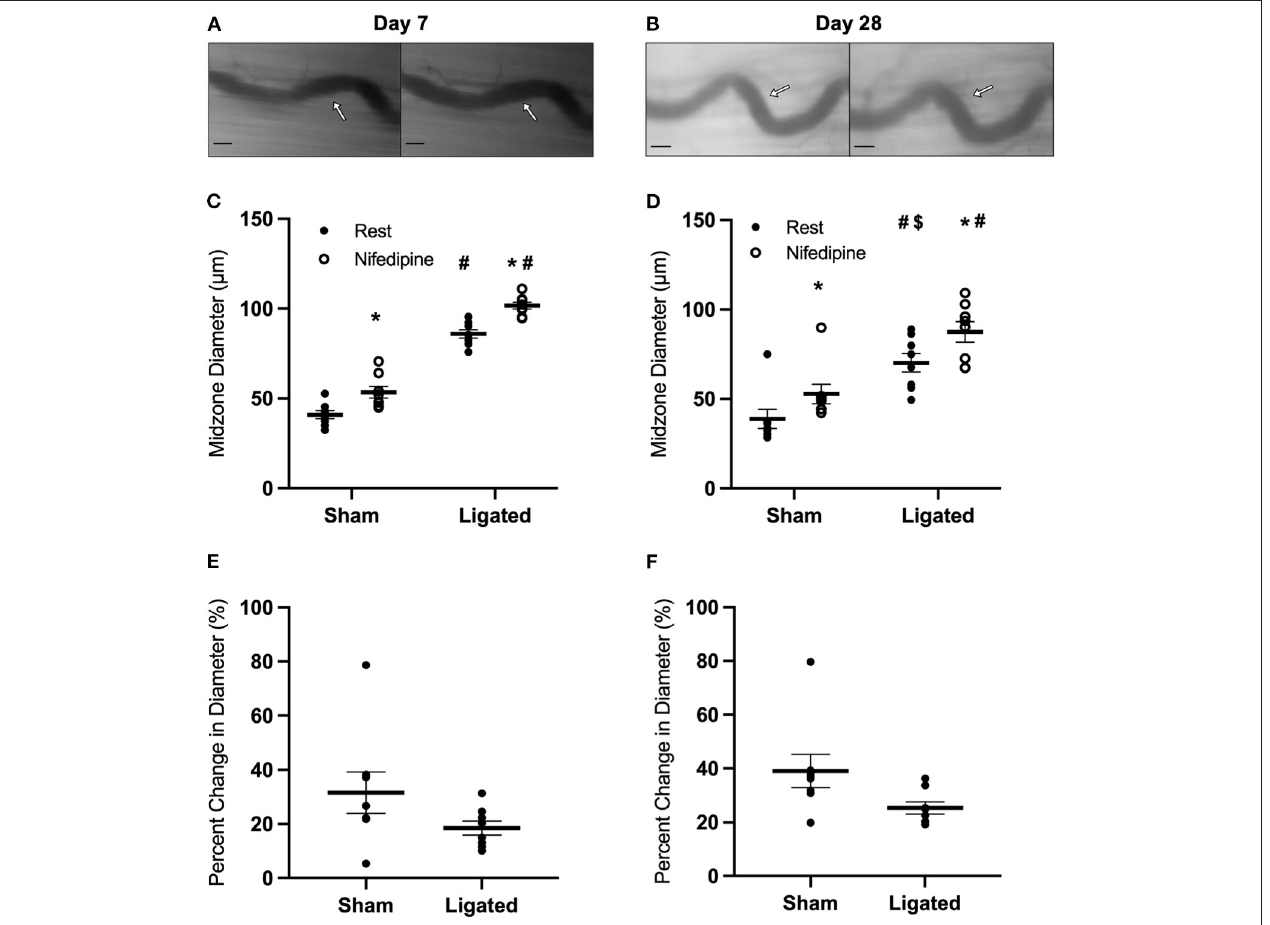
FIGURE 4 | Collateral vessels are not more sensitive to L-type calcium channel inhibition at day 7 and 28. Collateral vessels were observed at the collateral midzone by intravital microscopy with transillumination at 7 days (A) or 28 days (B) post-femoral artery ligation in the left mouse hindlimb at rest (left) and following exposure to 10 − 4 M of L-type voltage gated channel inhibitor nifedipine (right); arrows indicate the enlarged collateral arteriole and scale bar represents 100 µ m. Calcium channel inhibition vasodilates collaterals at both day 7 ( C , n = 8) and day 28 ( D , n = 8). However, there is no difference in the vascular reactivity between the native and enlarged collaterals at both 7 days (E) or 28 days (F) post-femoral artery ligation. * p < 0.05 vs. resting, # p < 0.05 vs. sham, $ p < 0.05 vs. day